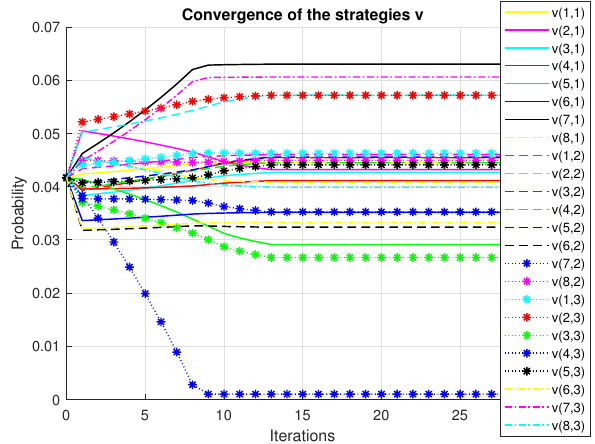
Figure 4. Convergence of the